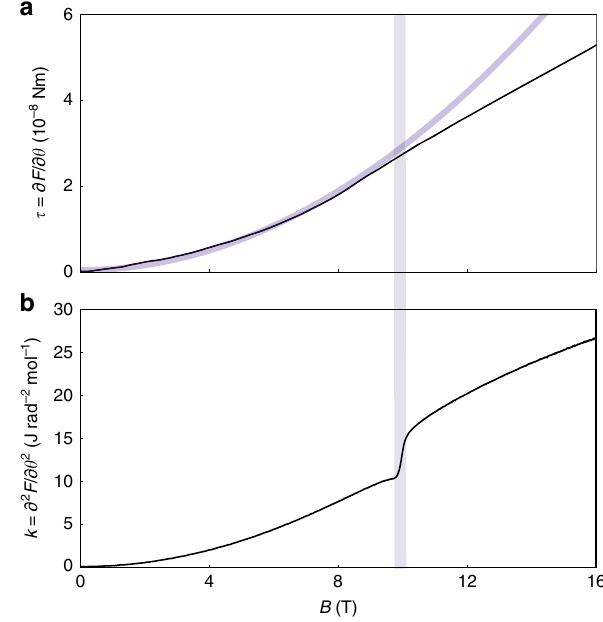
Fig. 4 Crossing the antiferromagnetic phase boundary in RuCl 3 . Comparison of a the magnetic torque τ inferred from the bending amplitude of a Seiko cantilever and b the magnetotropic coef fi cient k measured with resonant torsion magnetometry of RuCl 3 at T = 1.3K. Magnetic fi eld is applied at an angle ~10° from the honeycomb planes toward the crystallographic c axis. Both measurements probe the magnetic anisotropy between the in-plane and out-of-plane fi eld orientations (i.e., α = ±( χ || − χ ⊥ ), where χ || and χ ⊥ are with respect to the honeycomb planes). The gray band highlights the fi eld position of the suppression of long-range antiferromagnetic order. At the phase transition, the torque shows a deviation from the low- fi eld quadratic response (blue curve), while the magnetotropic coef fi cient features a sharp